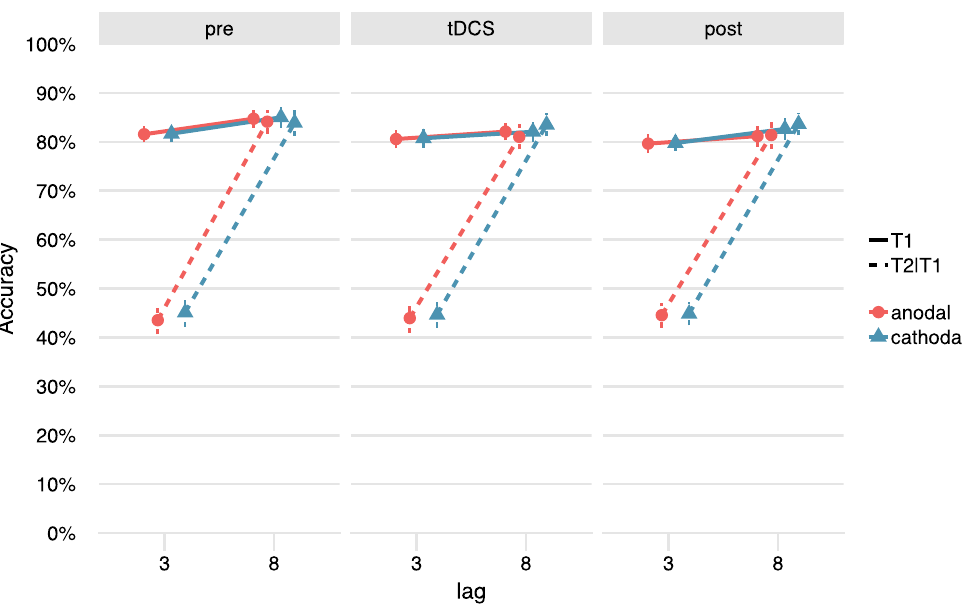
Fig 3. No effects of tDCS on the attentional blink at the group level. There was a clear attentional blink effect: a lower % T2 accuracy (given T1 correct: T2|T1; dashed lines) for lag 3 (T2 presented inside the attentional blink window) than lag 8 (T2 presented outside the attentional blink window, on par with T1 accuracy). However, the attentional blink did not change systematically over stimulation conditions (anodal, cathodal) and blocks (pre, tDCS, post). T1 accuracy (solid lines) was also not affected by